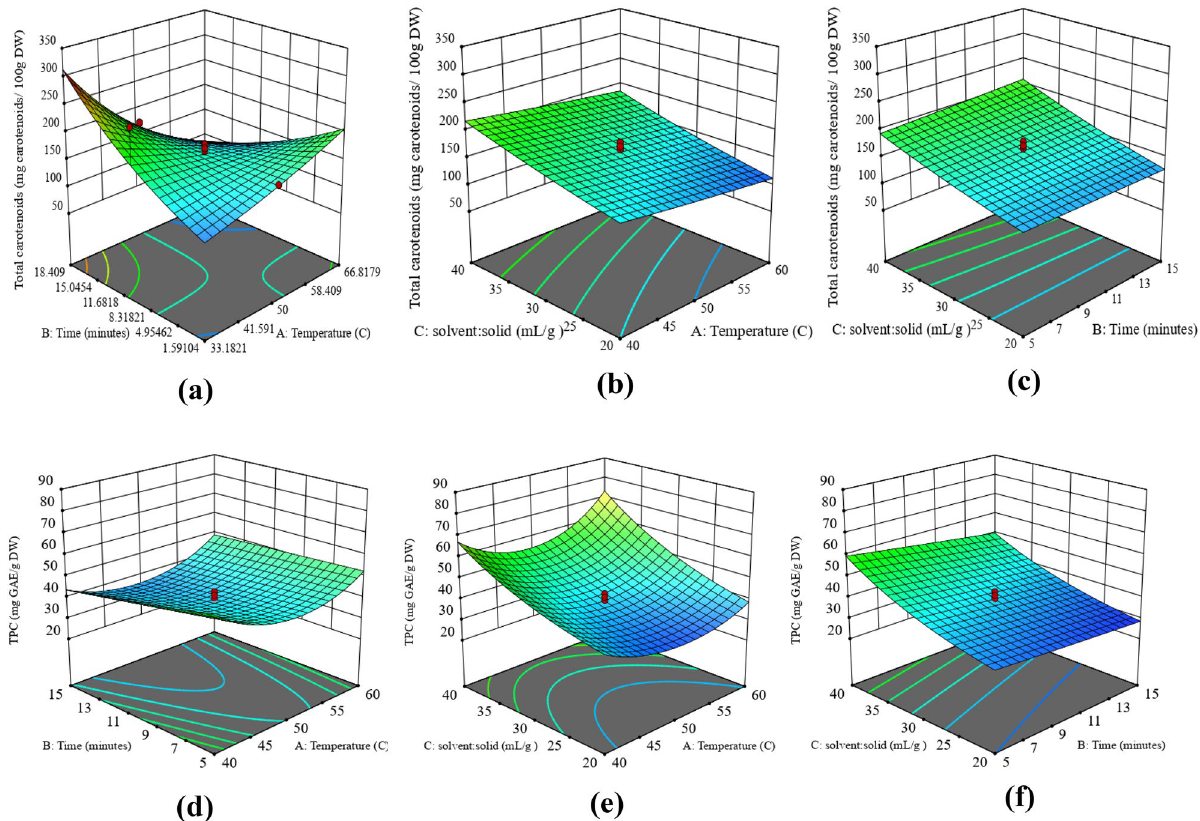
Figure 3. Response surface plots for representation of the combined effects of ( a ) A and B on TCC, ( b ) A and C on TCC ( c ) B and C on TCC, ( d ) A and B on TPC, ( e ) A and C on TPC ( f ) B and C on TPC (A: Temperature (°C), B: Time (min), C: Solid to solvent ratio